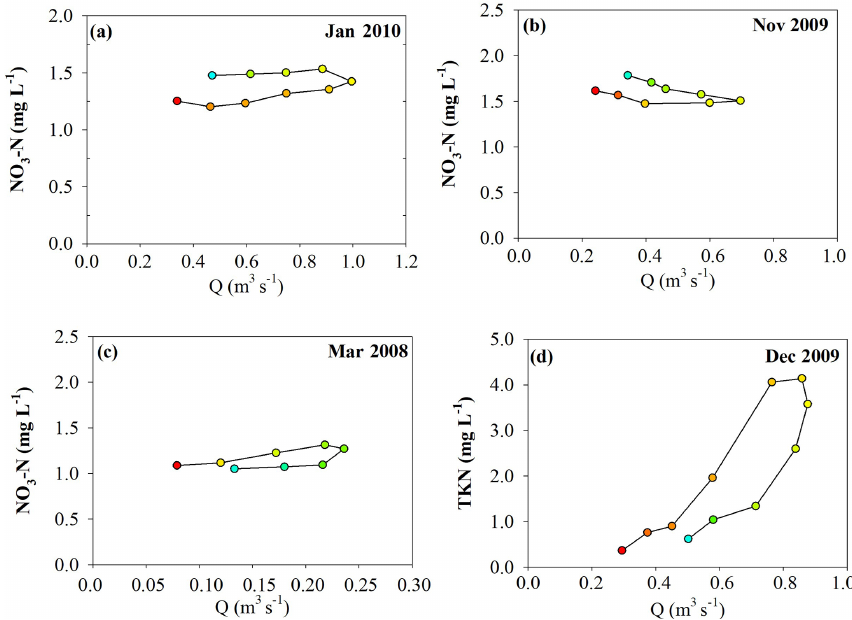
Figure 5. Examples of different types of NO 3 − (a–c) and TKN (d) hysteresis patterns observed in the Corbeira catchment during the monitoring period, where red indicates the start and blue the end of the runoff events. (a) Enrichment with a counterclockwise pattern. (b) Dilution with a counterclockwise pattern. (c, d) Enrichment with a clockwise